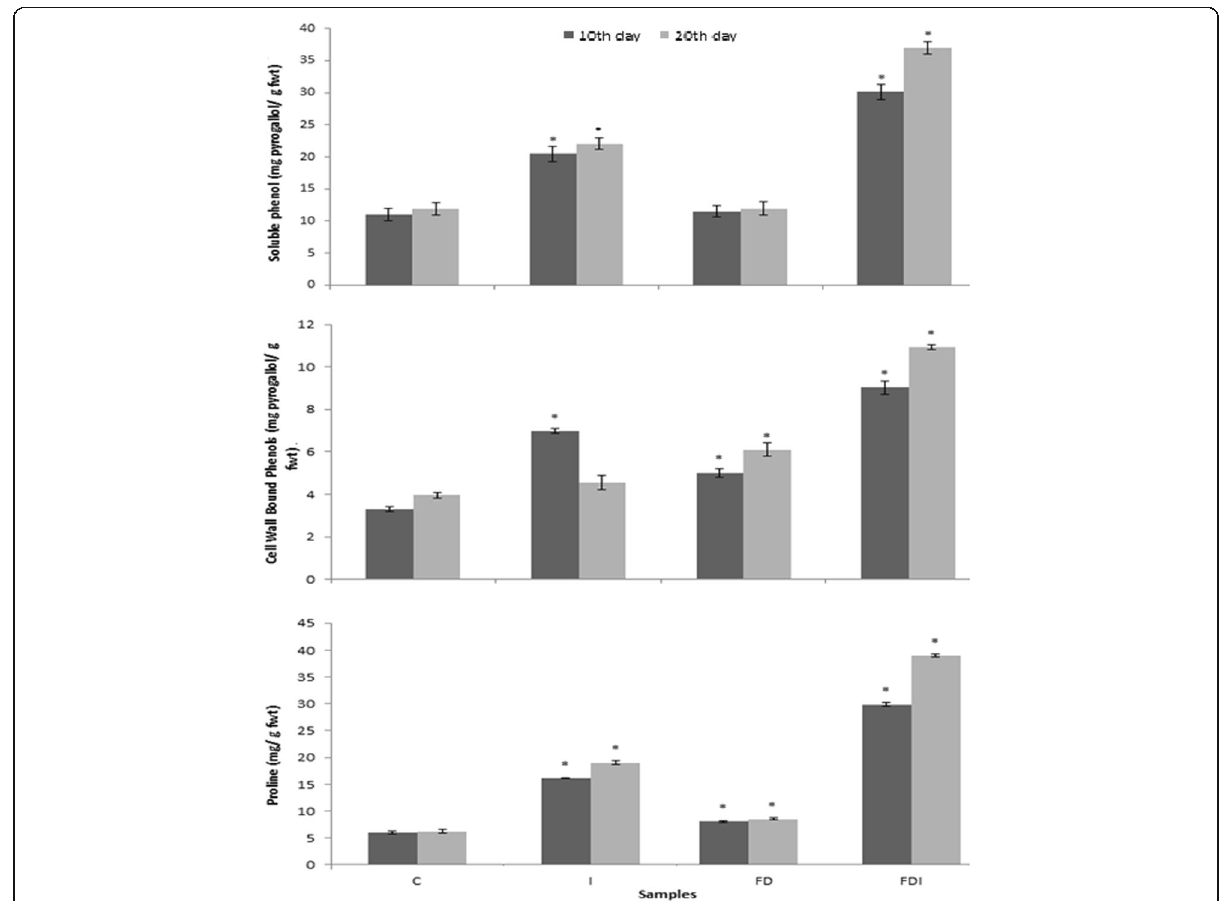
Fig. 4 Effect of defensin priming on antioxidant compounds (free soluble and cell wall bound phenols and proline) in plants under Fusarium infection. C: Control plants (plants grown from non-primed grains in non-infected soil, FD: plants grown from defensin primed grains in non-infected soil, I: plants grown from non-primed grains in Fusarium infected soil and FDI: plants grown from defensin primed grains in Fusarium infected soil. The columns followed by asterisks are significantly different from the control according to paired-samples t test. The bars represent the standard error. Values are means of three